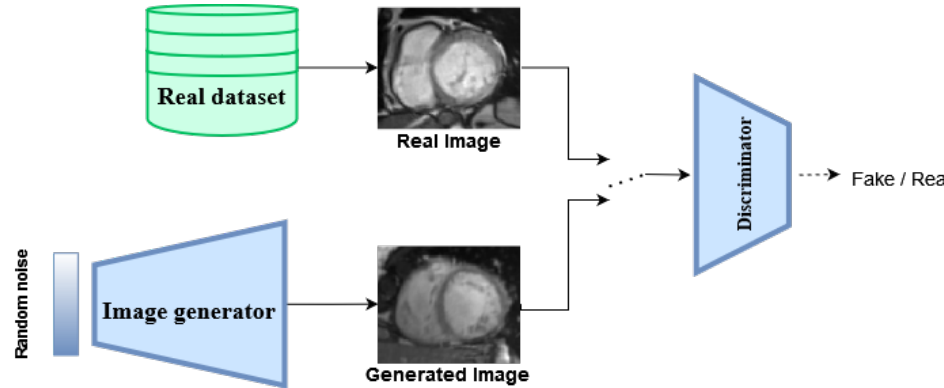
Figure 1. Flowchart of a traditional GAN